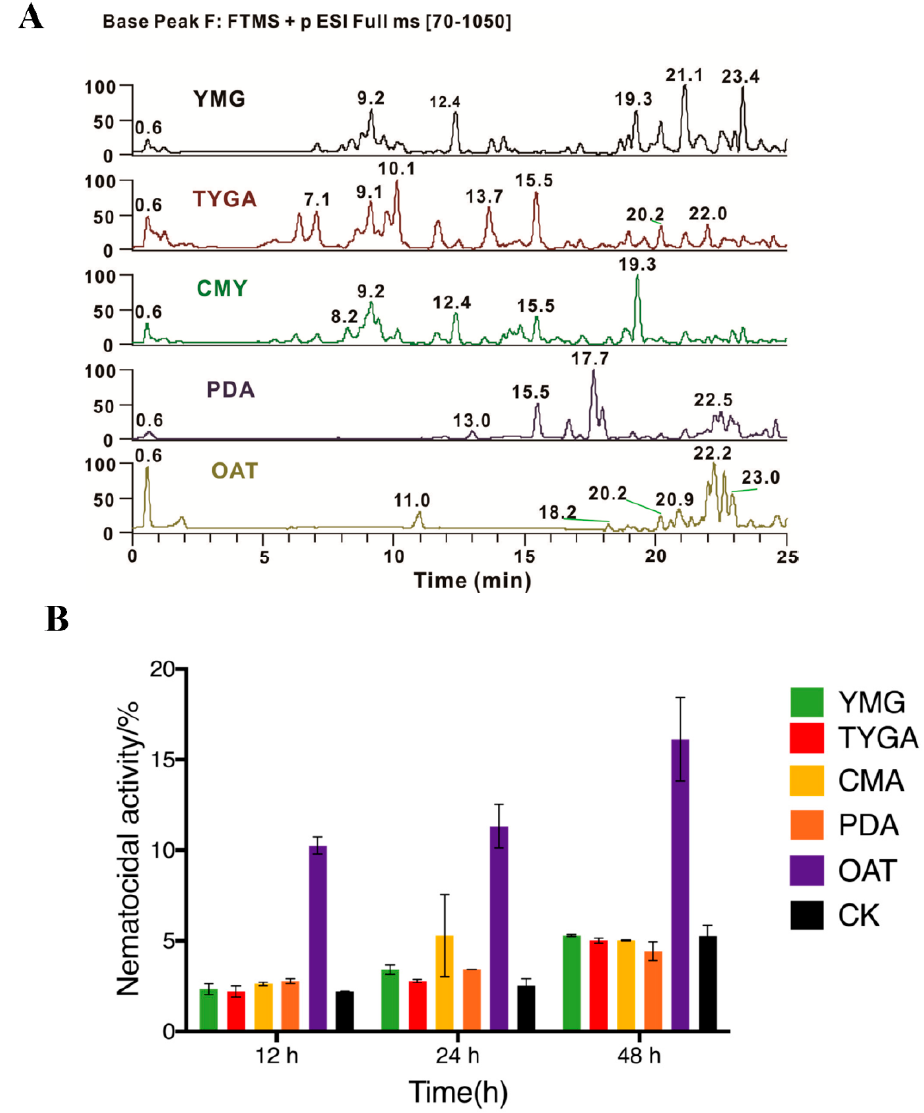
Figure 4. Results of culture medium screening based on UPLC profiling and nematicidal activity assessment. ( A ) Profiles of crude extracts produced through the fermentation of P . lavendulum on five solid media. ( B ) Nematicidal activities of crude extracts obtained from different media.